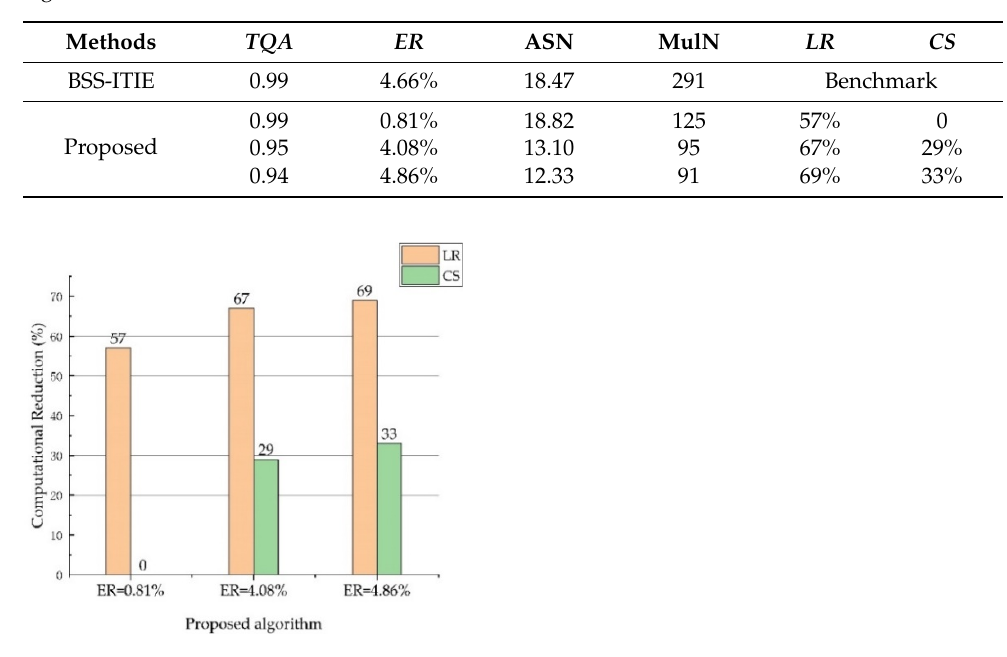
Figure 5. Bar graph representation of Table 6. Table 6. Computational savings comparison between the BSS-ITIE [28] method and the proposed algorithm.